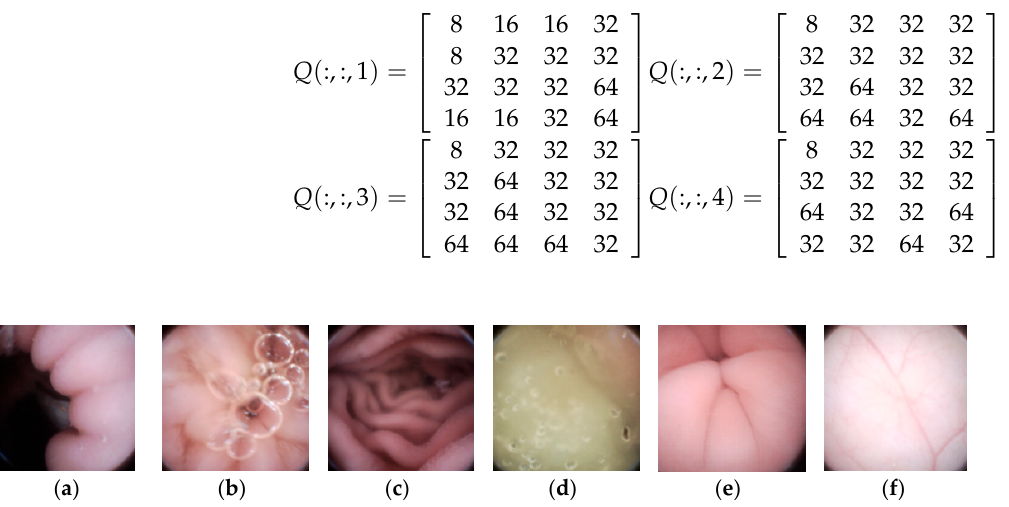
Figure 10. Six typical WCE images from the dataset (Interpolated from raw Bayer pattern) ( a , c , e ) have rich villi and folds, ( b , d ) have bubbles, ( f ) is full of vessels.